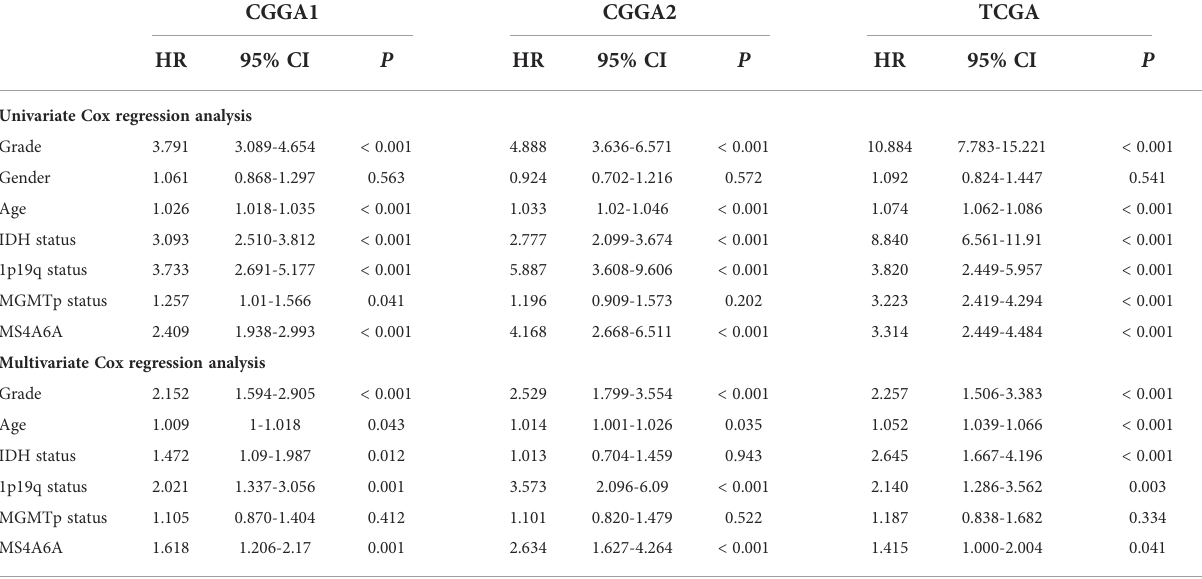
TABLE 1 Cox regression analysis of the clinical variables, and survival in the CGGA1, CGGA2 and TCGA